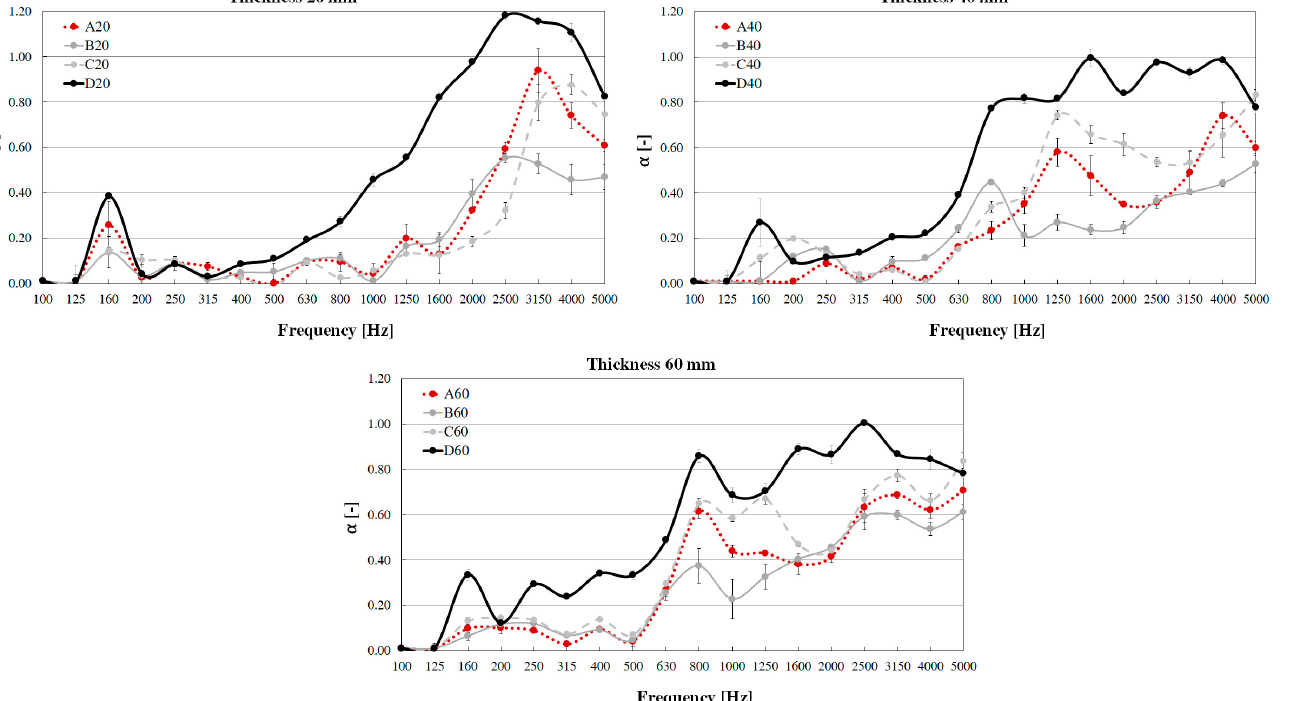
Figure A2. Comparison of the absorption coefficients for samples A–D with different thicknesses obtained from multiple layer combinations (20 + 20 and 20 + 40 mm). Sample A: crushed normal weight aggregates 4–8 mm; Sample B: round lightweight aggregates 4–8 mm; Sample C: round lightweight aggregates 2–4 mm; Sample D: round lightweight aggre- gates 0.5–1 mm.